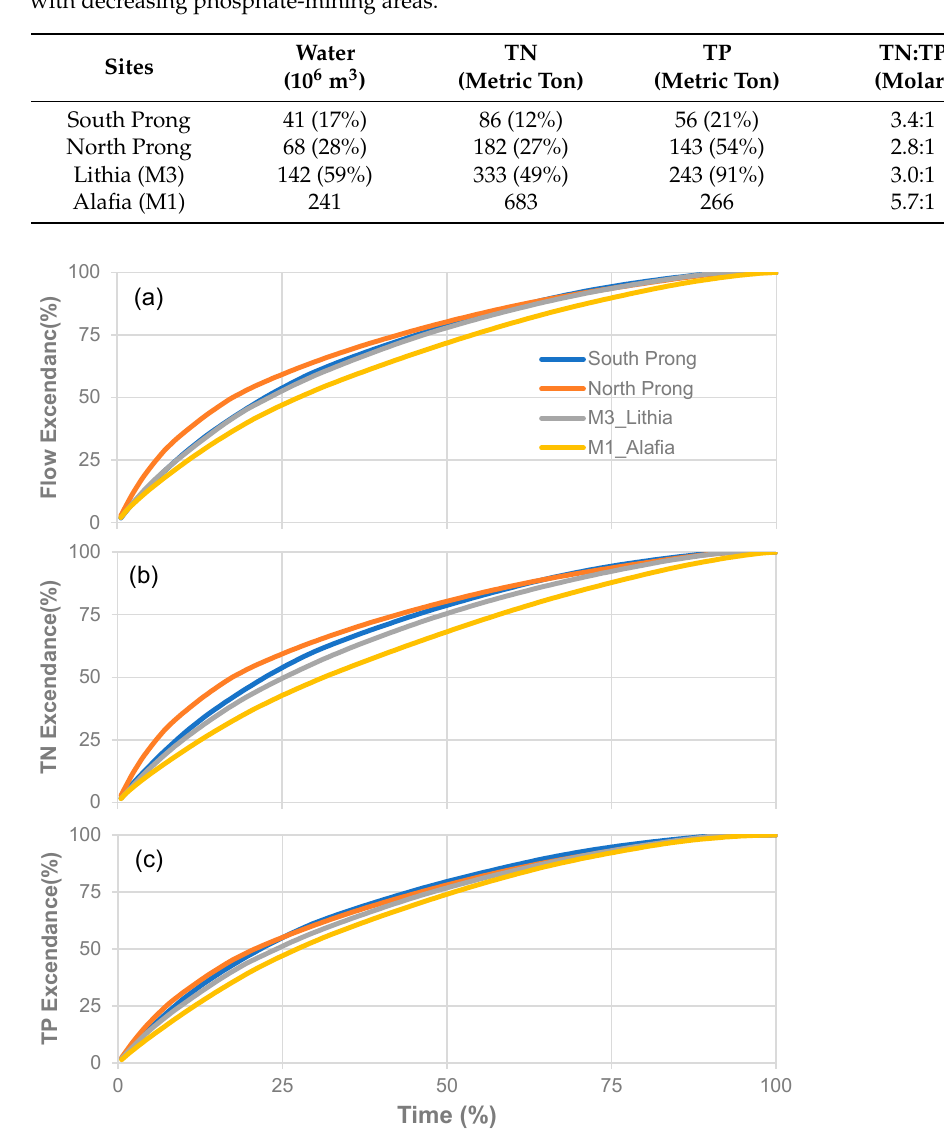
Figure 3. Cumulative ( a ) water flow duration, ( b ) total nitrogen (TN), and ( c ) total phosphorus (TP) export as a function of time in South Prong, North Prong, and mainstem sites M3 and M1 of the Alafia River Watershed. Table 3. Correlation coefficients between land-use and nitrogen and phosphorus forms in the streamwaters of the Alafia River Watershed over 23 sampling events (April–October 2009). Land Use